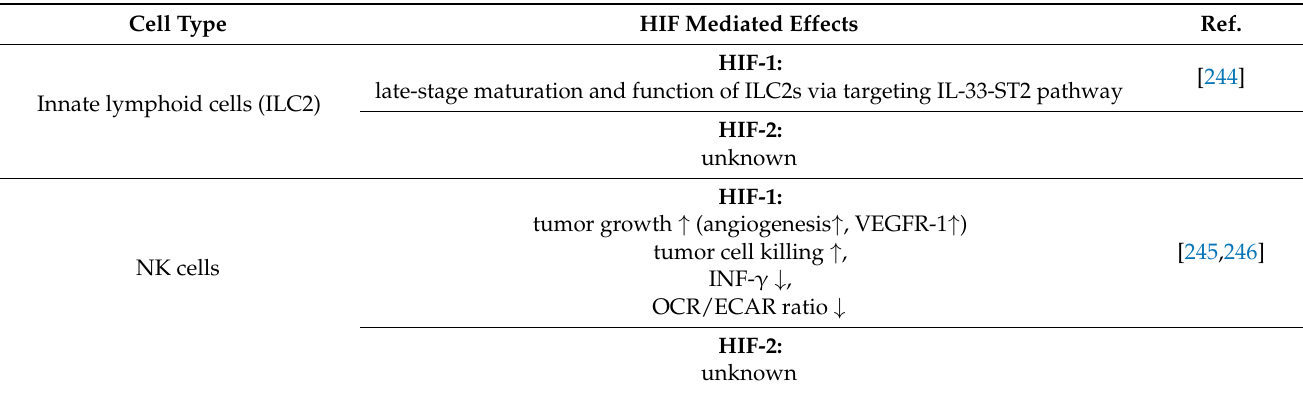
Table 3. HIF-mediated effects in innate lymphoid